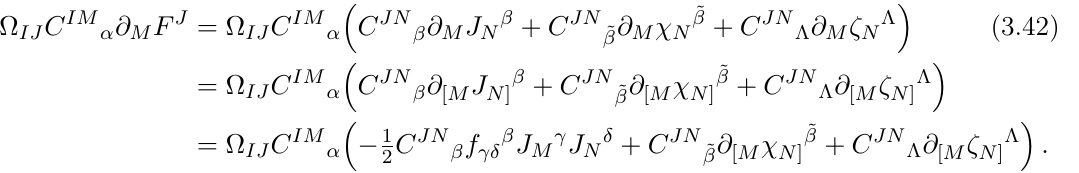
table 2, e.g., for K 7 (cid:17) K m 1 :::m 7 at ( p; q ) = ( (cid:0) 1 ; (cid:0) 1) we introduce at field strength F